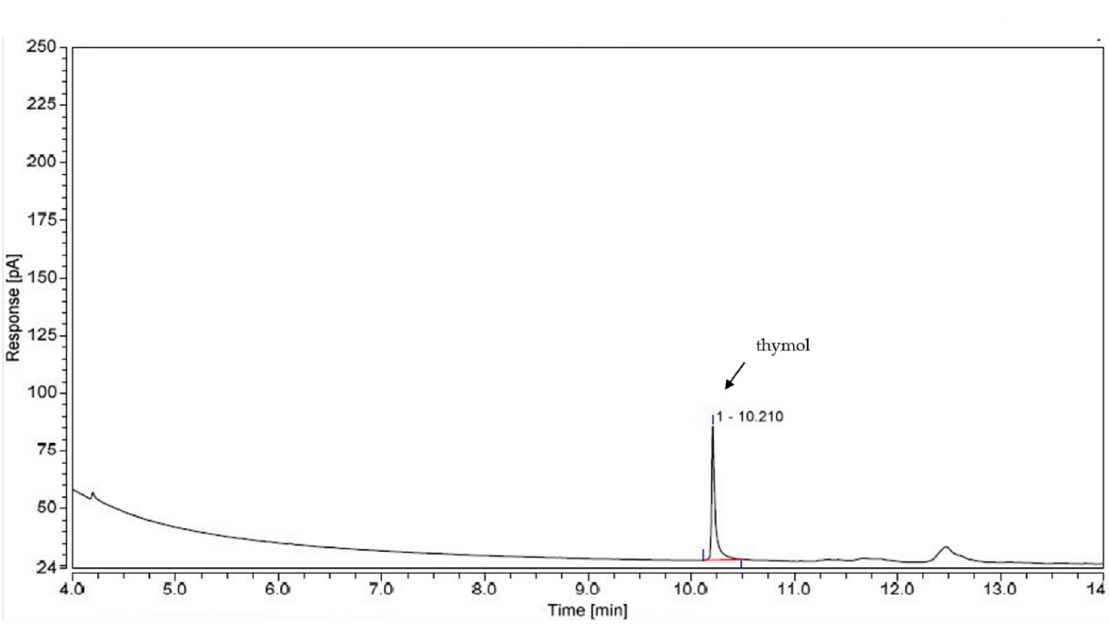
Figure 3. GC analysis of thymol from Plextranthus amboinicus.